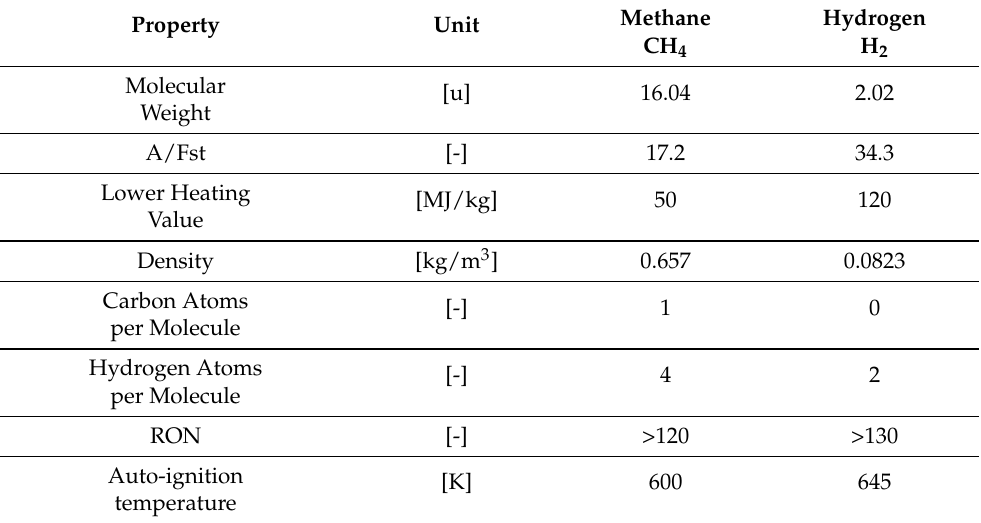
Table 2. Hydrogen and methane fuel